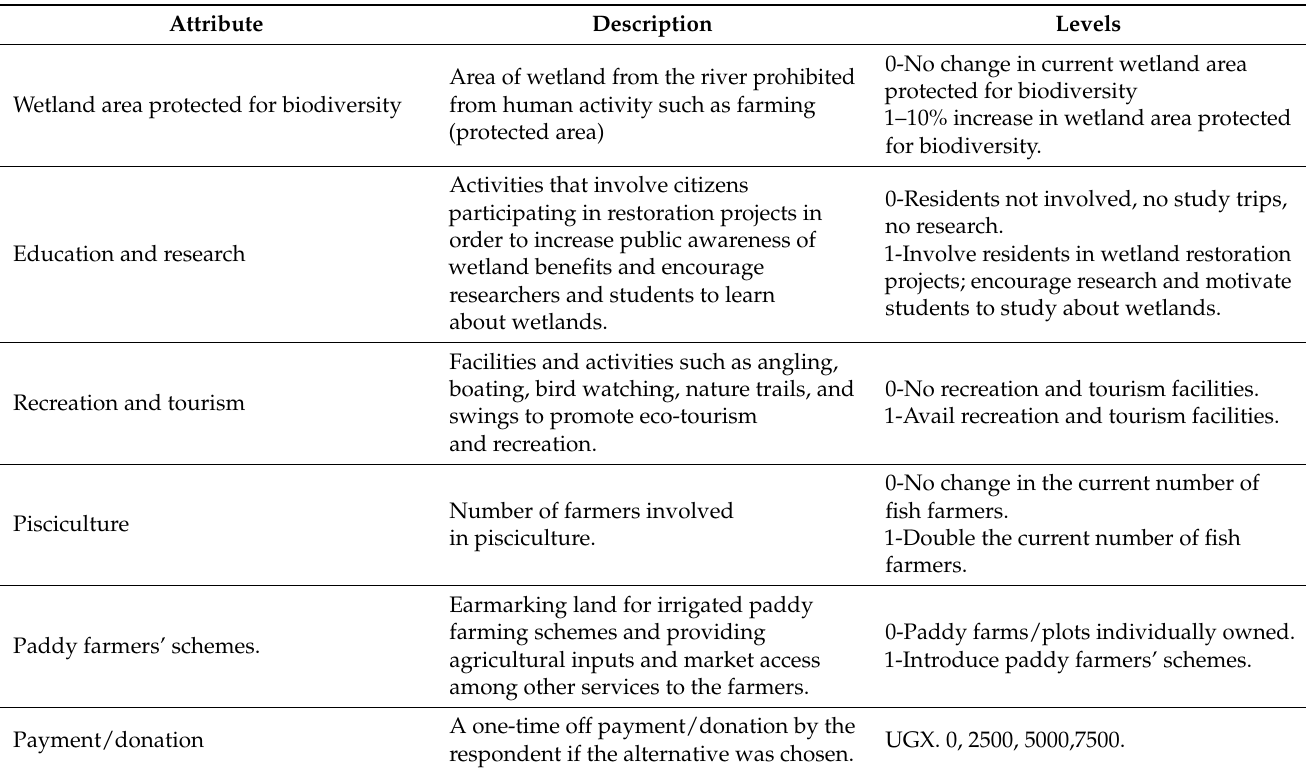
Table 1. Attributes and levels used in the DCE